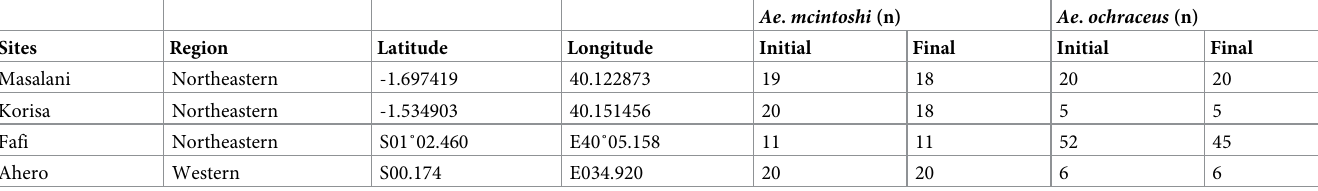
Table 1. Information on sampling sites for the two mosquito species collected in Kenya.